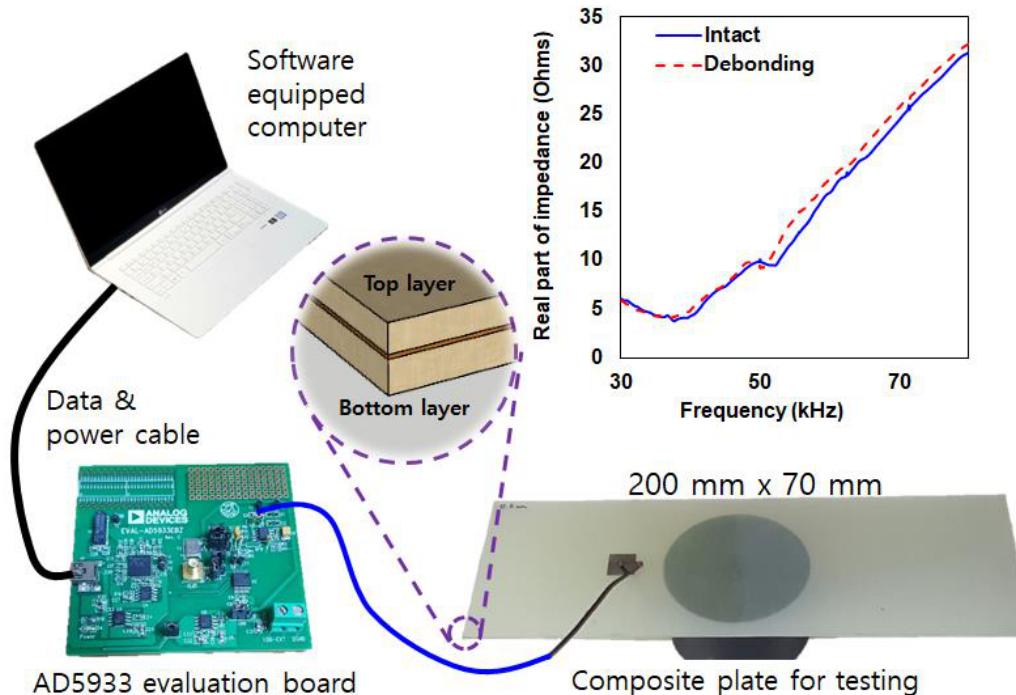
Figure 1. Experiment setup of the electromechanical impedance (EMI) technique for a debonding test.